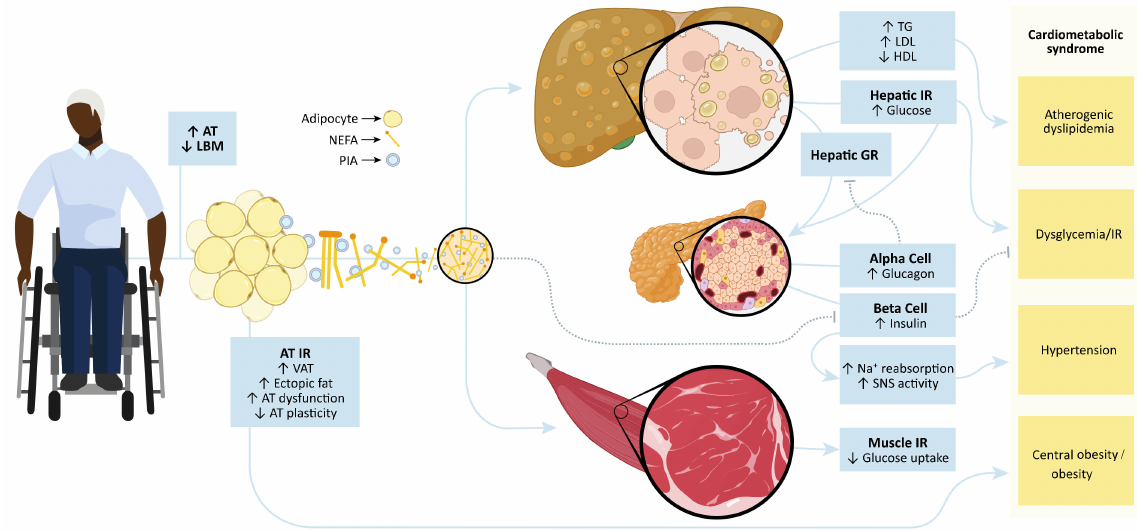
Figure 4. Spinal cord injury (SCI) morbidity presented as a continuum from the onset of neurogenic obesity to the development of cardiometabolic syndrome. SCI results in neurogenic obesity through the loss of metabolically active lean body mass (LBM) and a concurrent accumulation of adipose tissue (AT). Obesity-induced hypoxia results in the dysregulation of AT, marked by a loss of AT plasticity and the secretion of non-esterified free fatty acids (NEFA) and proinflammatory adipokines (PIA). NEFA enter peripheral circulation, resulting in visceral (VAT) and ectopic fat deposition, thereby promoting systemic insulin resistance (IR). NEFA deposition in the liver stimulates increased glucose production and hepatic IR. Hepatic NEFA accumulation also promotes atherogenic dyslipidemia through triglyceride (TG) lipogenesis and the increased and decreased production of LDL- and HDL-cholesterol, respectively. NEFA deposition also occurs in the nearby pancreas, inducing β -cell dysfunction by lipotoxicity and dysglycemia/diabetes. NEFA storage in the liver also promotes hepatic glucagon resistance (GR) and hyper-aminoacidemia that stimulates glucagon secretion to compensate for hepatic GR. Hyperglucagonemia facilitates increased hepatic glucose release. In skeletal muscle, increased NEFA deposition promotes IR, inhibiting insulin-mediated glucose uptake. Overall, the systemic state of IR results in hyperinsulinemia. Hyperinsulinemia may increase sodium (Na + ) reabsorption and sympathetic nervous system activity above the level of SCI, contributing to hypertension. PIA alter signaling pathways contributing to atherogenic dyslipidemia, hypertension, and insulin resistance/dysglycemia environment. Collectively, when these metabolic morbidities co-manifest, they present as cardiometabolic syndrome. Arrows represent stimulation/enhancement, flat ends demonstrate inhibition/repression, and dashed lines represent a progressive decrease in a pathway. Caption adapted from